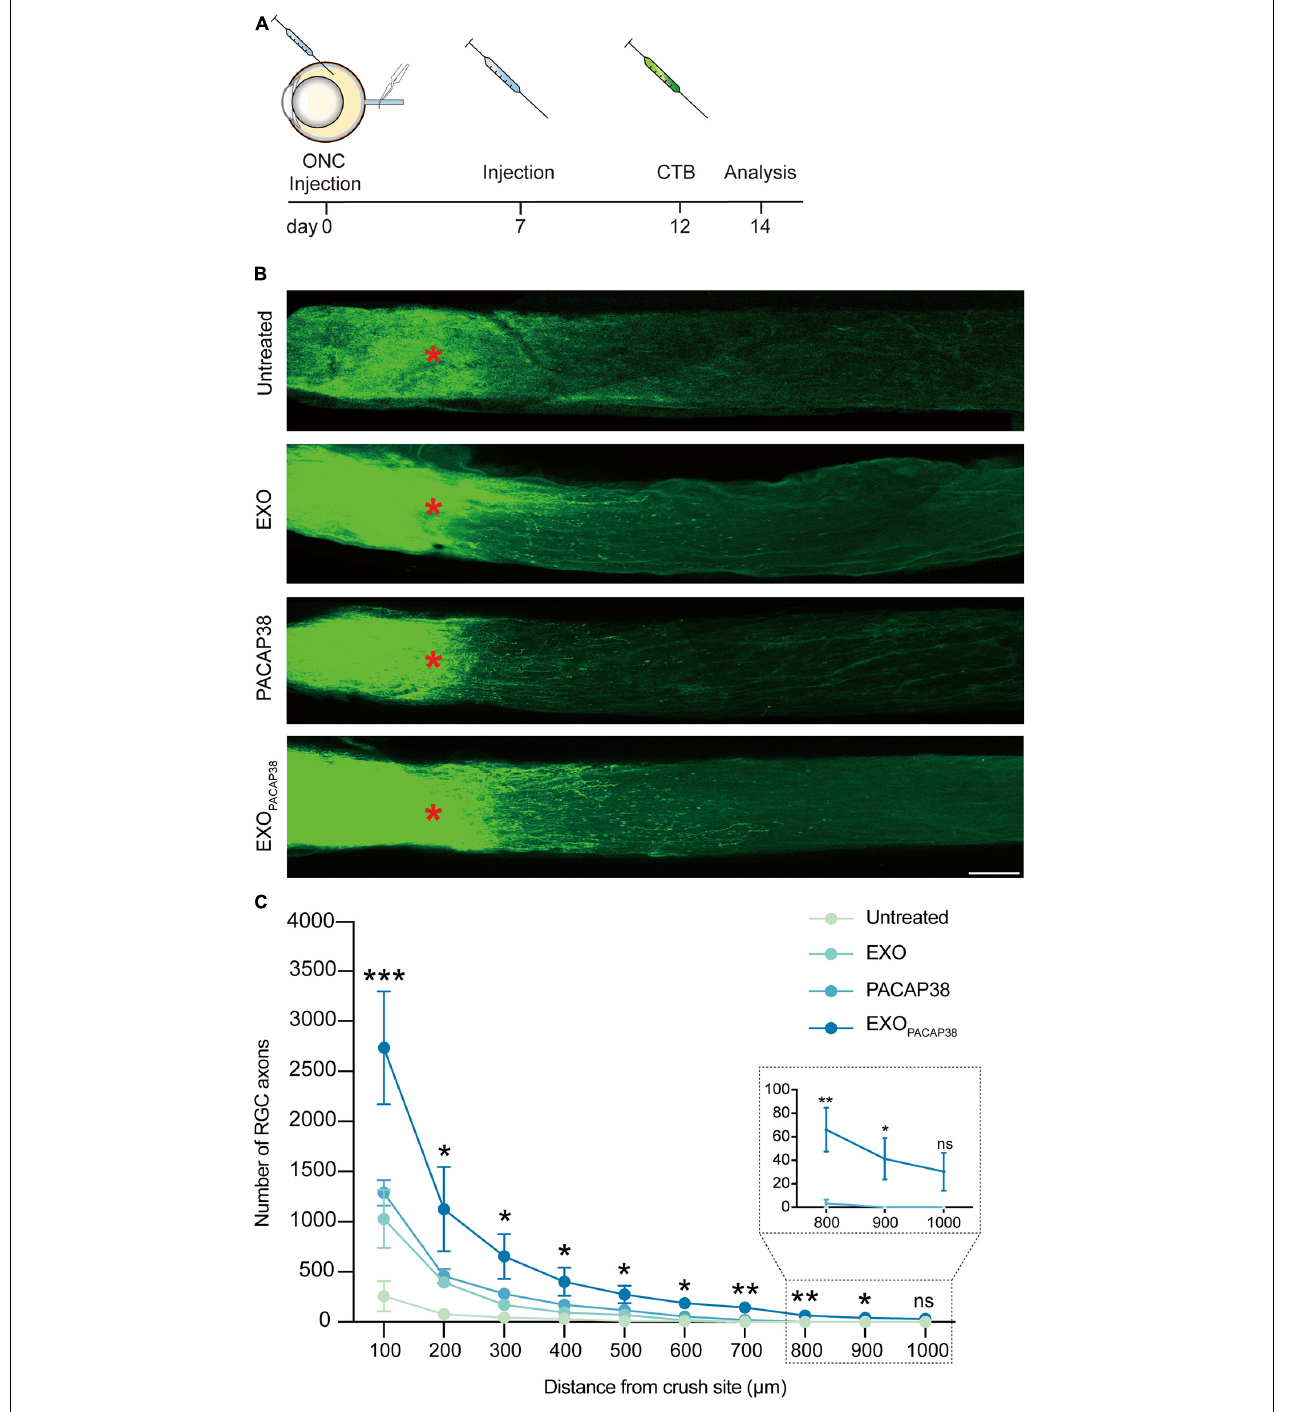
FIGURE 3 | Evaluation of optic nerve regeneration in EXO PACAP 38 -treated rats after ONC. (A) Experimental timeline. ONC was performed on rats followed by intravitreal injection of EXOs, PACAP38, and EXO PACAP 38 . After 7 days, the rats were given a second injection. Axons were traced with CTB-conjugated Alexa Fluor 488 at 2 days before animal sacrifice. (B) Laser scanning confocal microscope images showing the regeneration of optic nerve axons at 14 days after injury, divided into the untreated, EXO-treated, PACAP38-treated, and EXO PACAP 38 -treated groups (scale bar = 100 µ m). Optic nerve axons were traced using CTB. Asterisks indicate the ONC site. (C) Quantitative analysis of optic nerve axon number in the range of 100–1,000 µ m from the crush site (red asterisks in B) ( n = 4; one-way ANOVA on Tukey’s multiple comparisons test,* P < 0.05, ** P < 0.01, *** P < 0.001, relative to the untreated group).